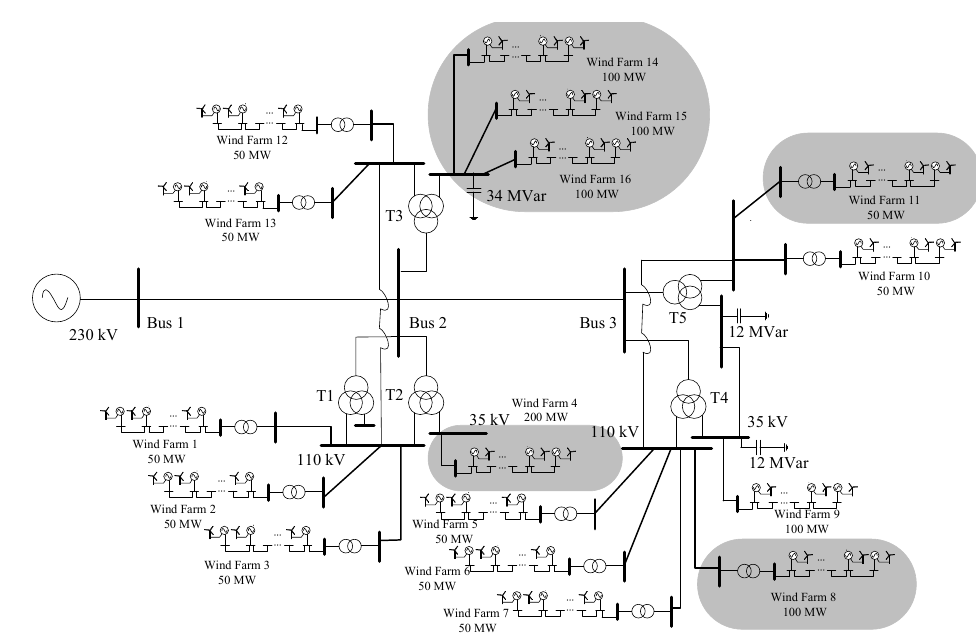
Figure 14. Schematic Structure Diagram of the Wind Power Base.